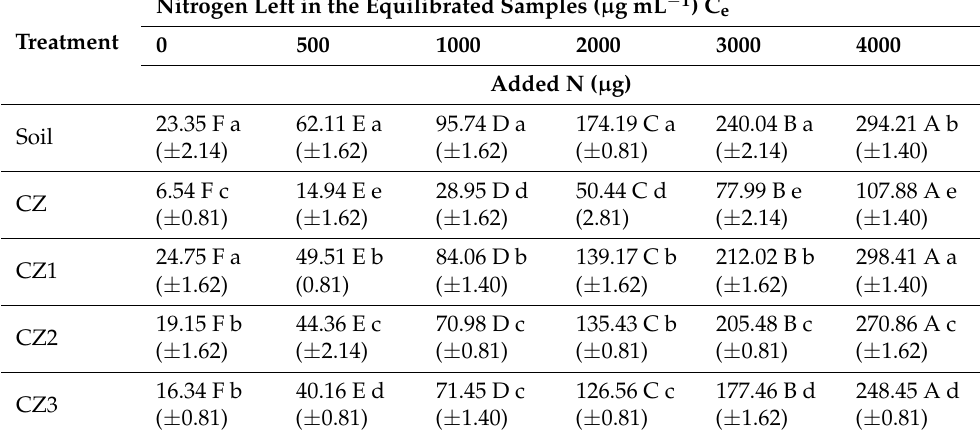
Table 4. Interactive effects of the different concentrations of nitrogen and treatments (Soil only, clinoptilolite zeolite only, and soil with different amounts of clinoptilolite zeolite) on nitrogen content.